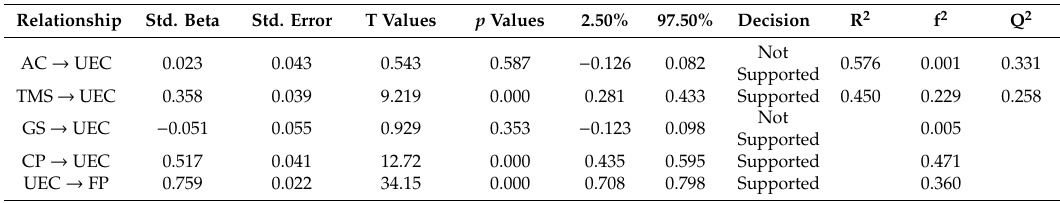
Table 10. Hypotheses testing results (direct e ff